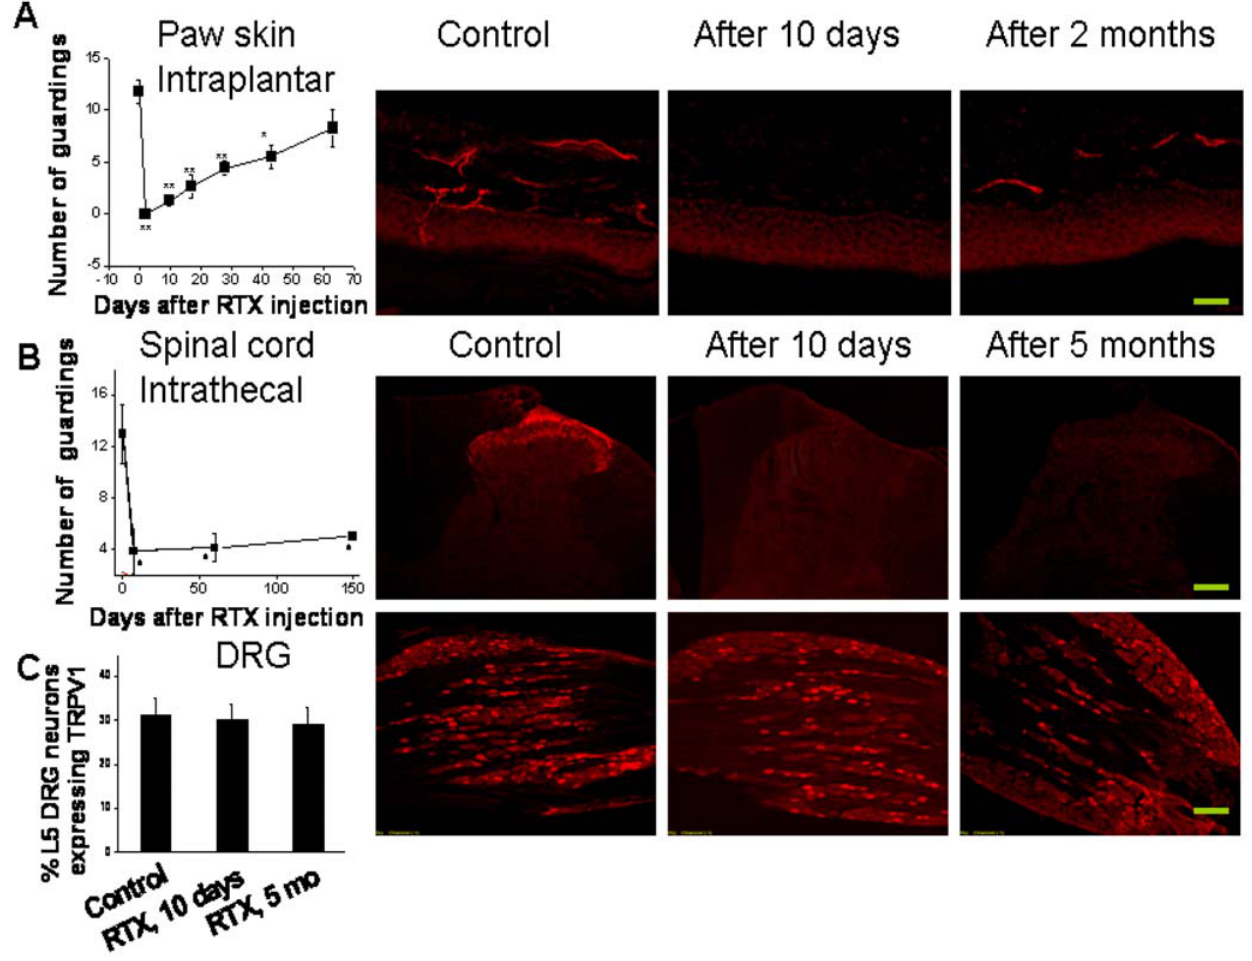
Figure 7. Loss and regeneration of TRPV1 expressing nerve terminals in the paw skin and spinal cord. A. Loss and recovery of capsaicin-induced nocifensive behavior within 60 days after intraplantar injection of RTX; TRPV1 staining 10 days and 2 months after RTX injection are shown. B . After intrathecal RTX injection, capsaicin-induced nocifensive behavior did not recover even after 5 months. TRPV1 staining after 10 days and 5 months of RTX injection are shown. C . TRPV1 staining in DRG is not affected by intrathecal RTX. Asterisks denote significant change. The scale bar is 50 (middle row) or 100 m m.